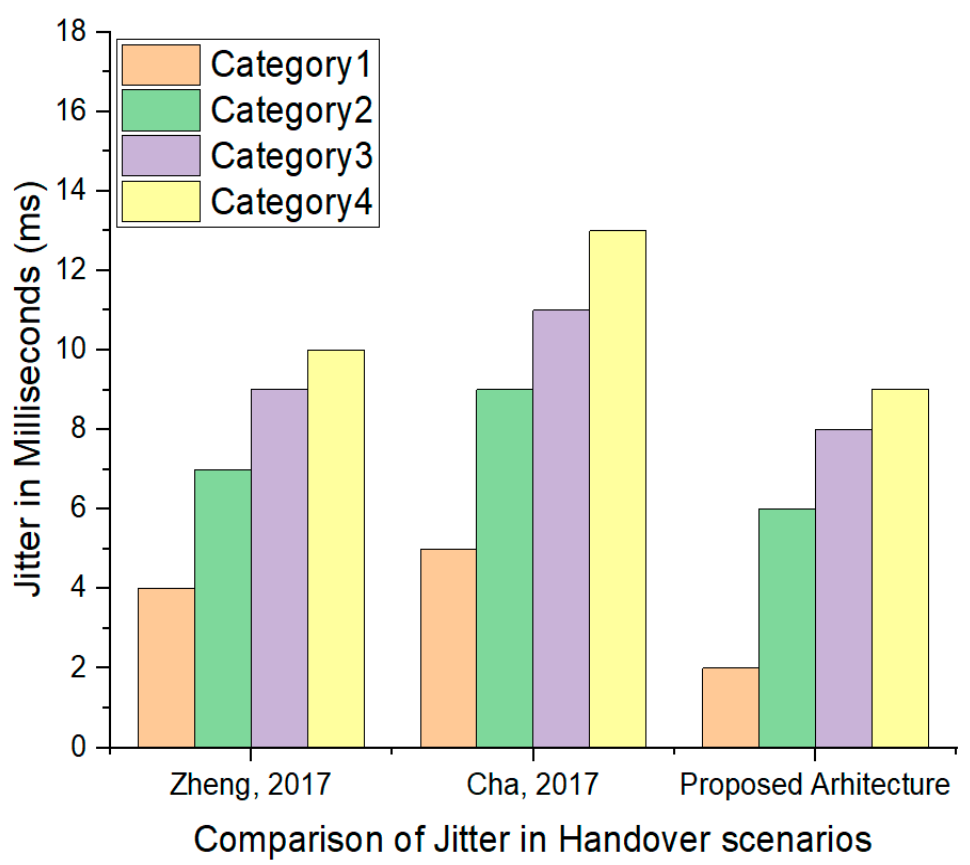
Figure 11. Comparison of jitter with [25] and [26] schemes proposed by (Zheng, 2017) and (Cha, 2017) in different scenarios.